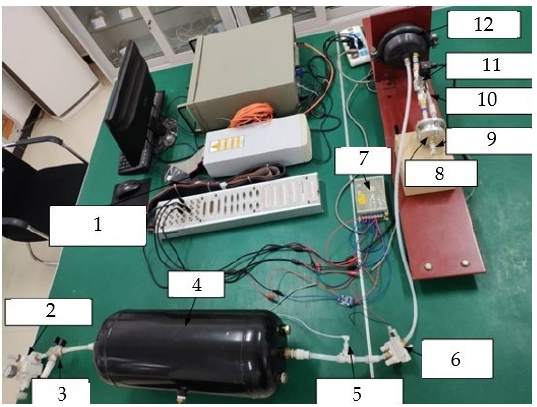
Figure 18. Brake pressure change rate measurement test platform. 1-dSPACE; 2-Precision pressure reducing valve; 3-On-off valve; 4-Air tank; 5-Pressure sensor; 6-Two-position five-way solenoid valve; 7-Power supply; 8-Isothermal container; 9-Pressure sensor; 10-Laminar flow resistance tube; 11-Differential pressure sensor; 12-Brake chamber.